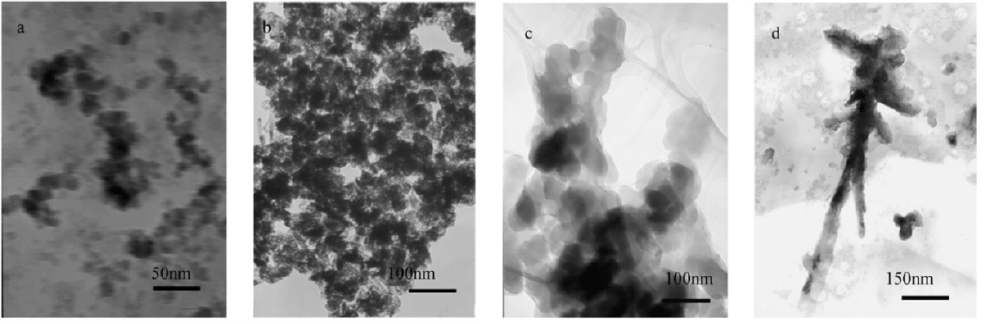
O mass ratio: (a) 0; (b) 12 19